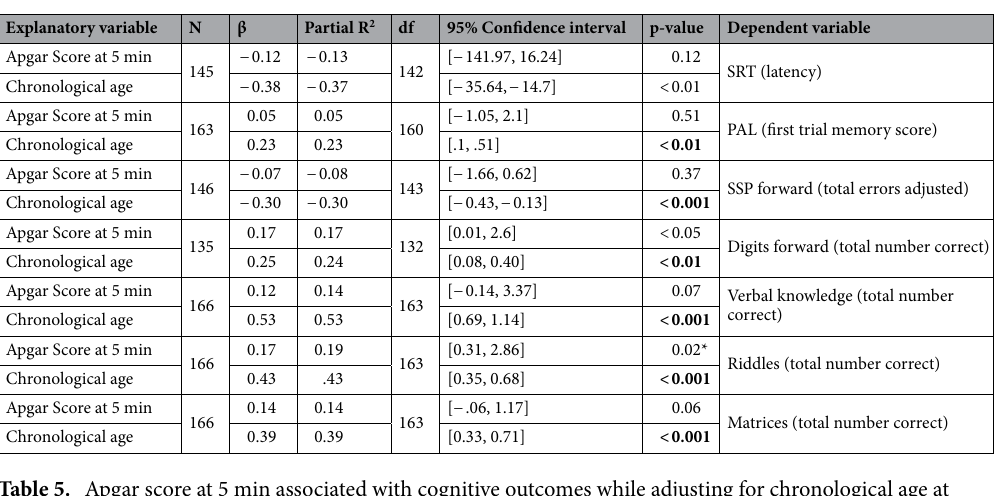
Table 5. Apgar score at 5 min associated with cognitive outcomes while adjusting for chronological age at time of cognitive testing: results from regression analyses. N sample size, R coefficient of correlation, df degrees of freedom, SRT simple reaction time, PAL paired-associates learning, SSP spatial Span, Digits Forward recall of digits forward. Bolded p-values are those which remained significant after Bonferroni correction (p ≤ 0.007) for multiple comparisons. Confidence interval corresponds to the unstandardized